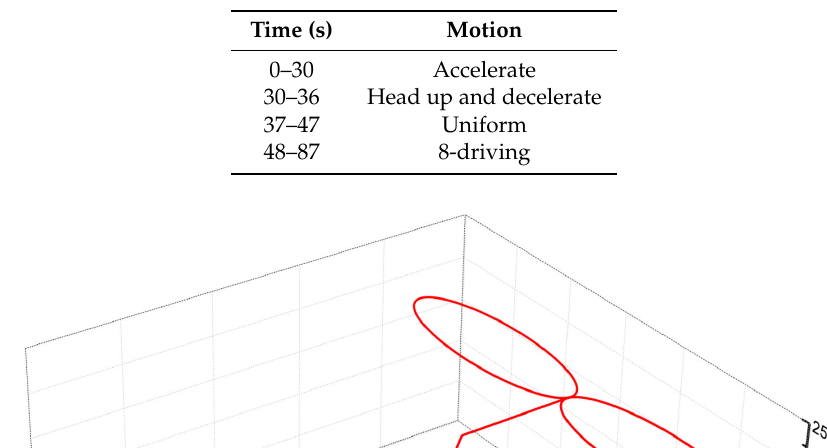
Table 1. Description of vehicle motion.